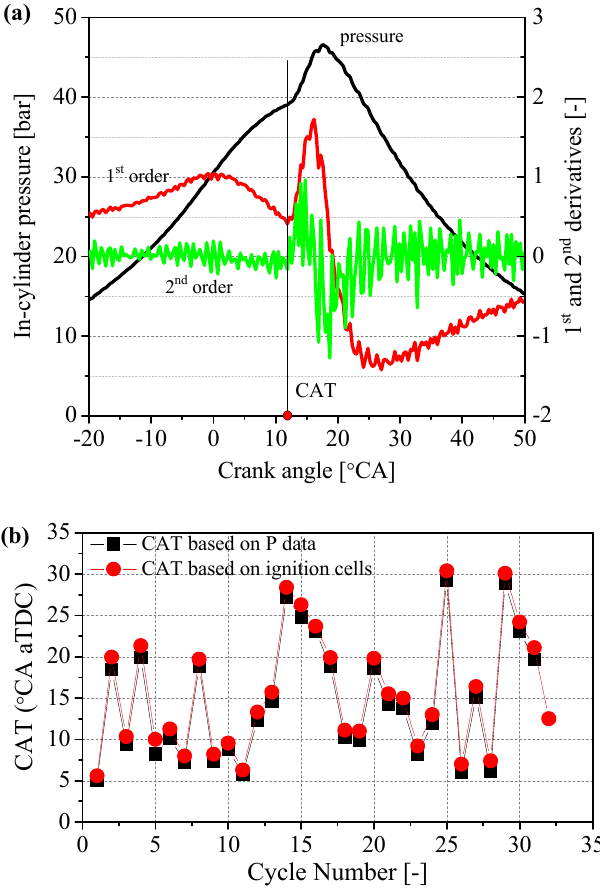
Figure 7. ( a ) The definition of the CAT based on the pressure data. ( b ) Comparison of CAT based on pressure data and auto-ignition cells in LES simulations.